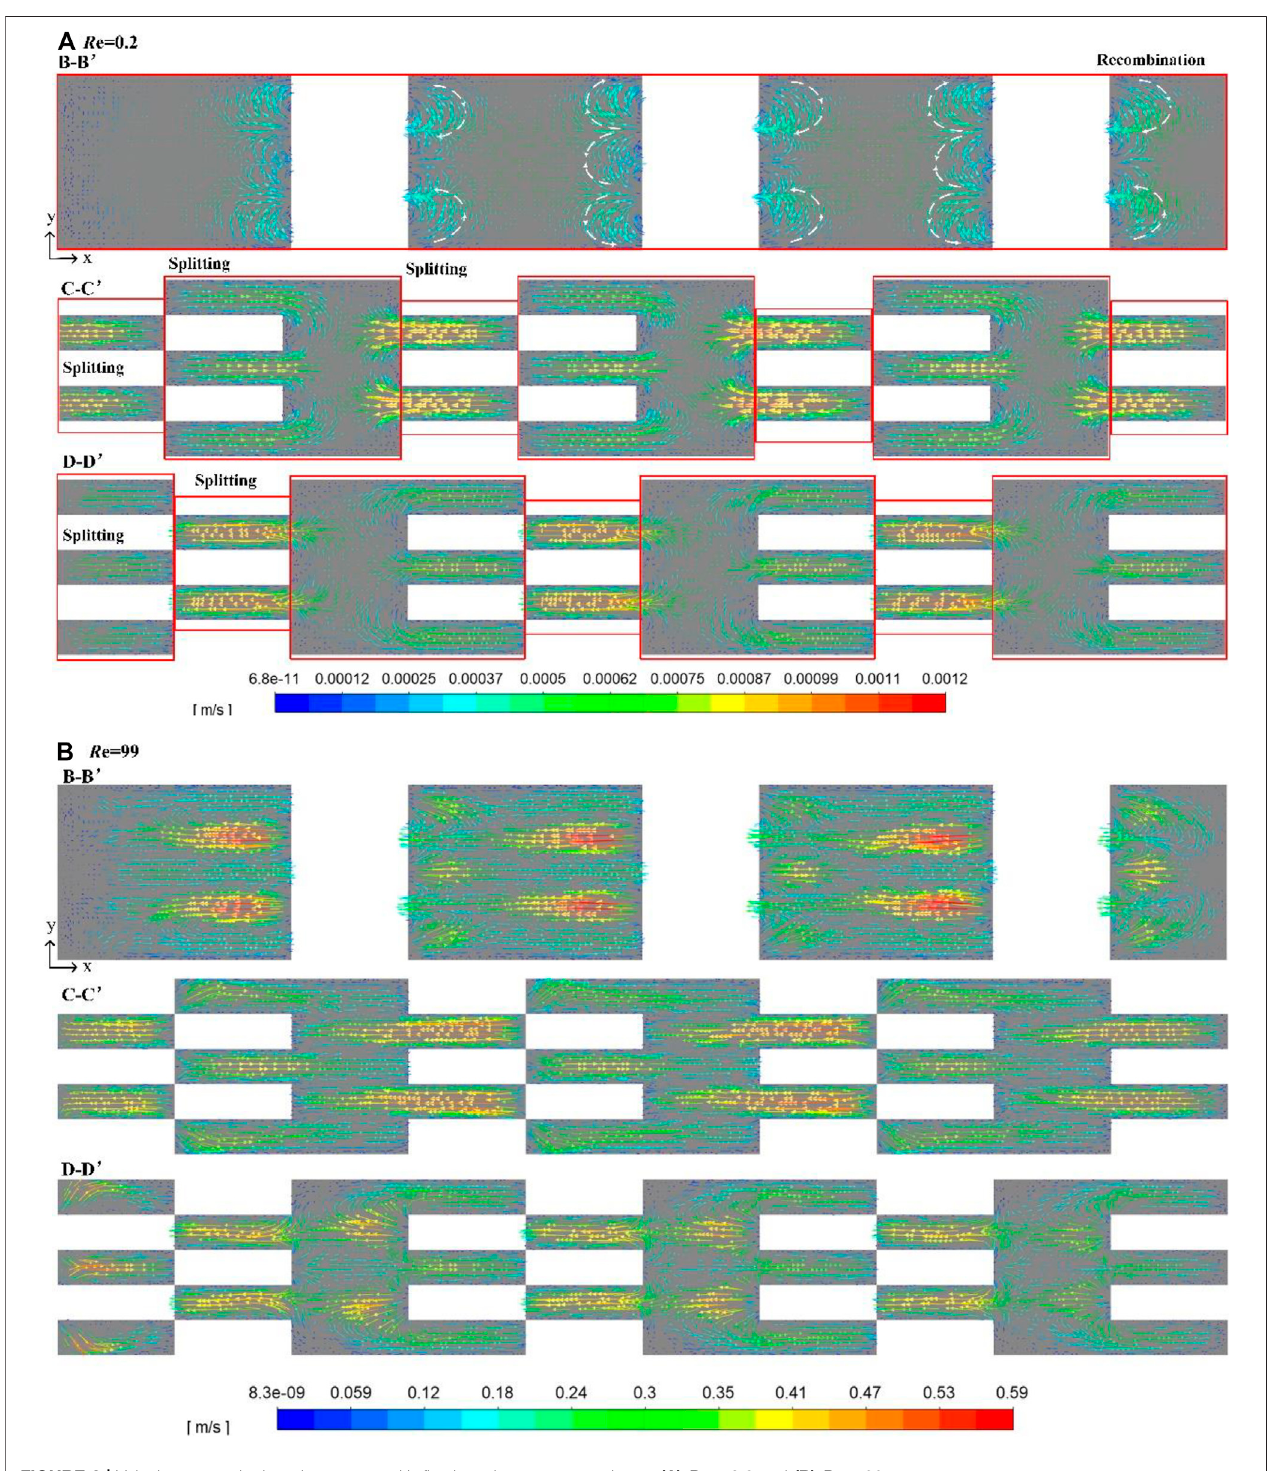
FIGURE 8 | Velocity vectors in the microreactor with fi ve-layer inserts on x-y planes: (A) R e (cid:1) 0.2 and (B) R e (cid:1) 99.